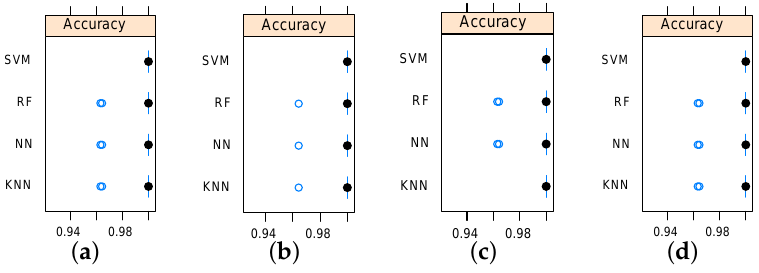
Figure 7. Box-and-whisker diagrams indicating the accuracy variation for the implemented classifiers. ( a ) based on the five top features using Information Gain (IG); ( b ) based on the five top features using Gain Ratio (GR); ( c ) based on the five top features using relief; ( d ) based on the five top features using